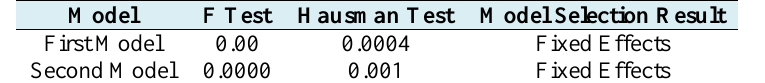
Table 2. Determining the type of Estimation of the Integrated Data